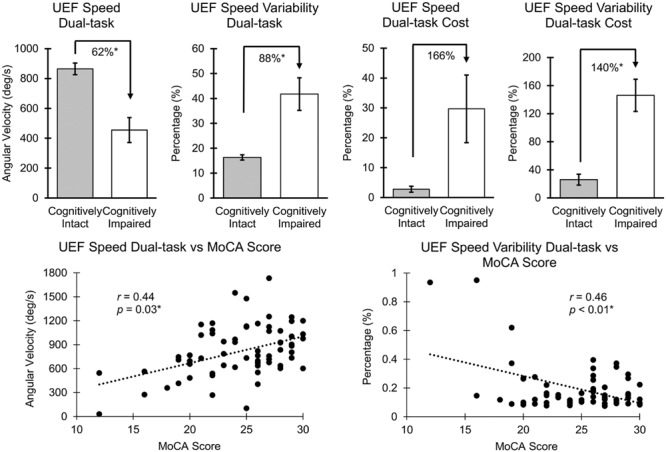
Association between UEF speed and speed variability with MoCA. Mean and standard error (SE) values of UEF parameters are presented, and the asterisk symbol represents a significant association. r values were not adjusted with age, gender, and BMI; p-values were adjusted with age, gender, and BMI.